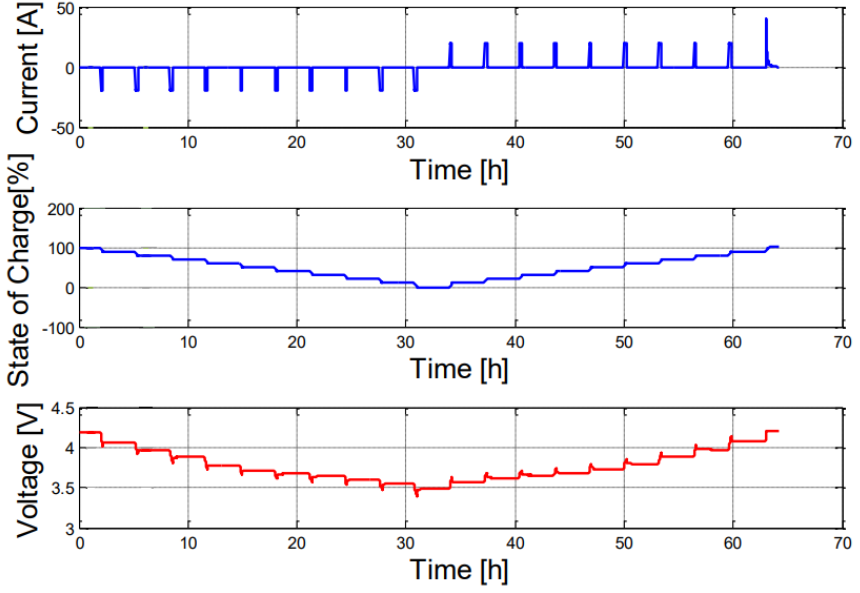
Figure 10. Open circuit voltage testing. Table 1. OCV measured values.